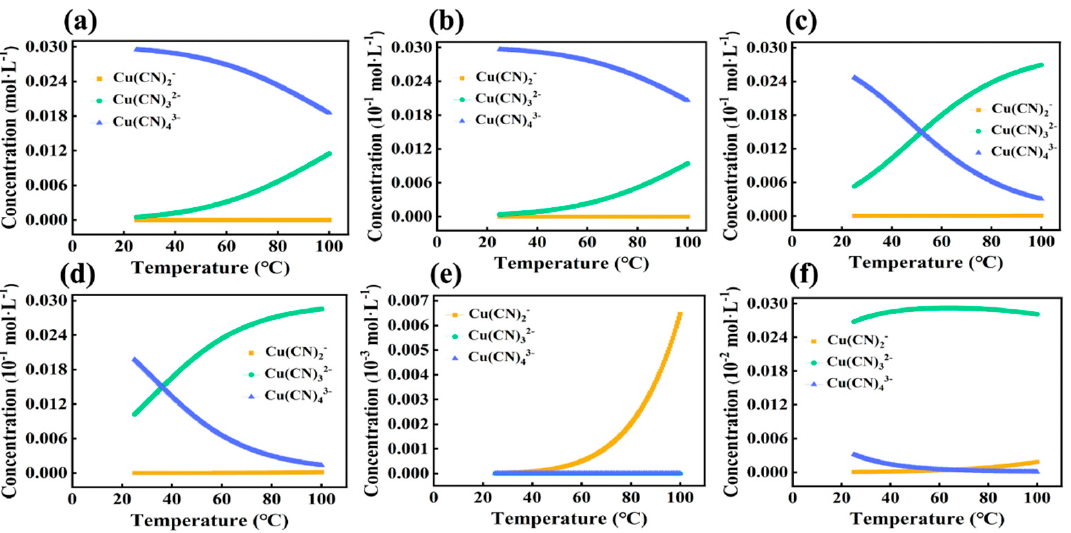
Figure 6. The OLI studio 11.0 was utilized to simulate the distribution of Cu(CN) 2 − , Cu(CN) 32 − , and Cu(CN) 43 − as a function of temperature under six different concentration gradients, with the follow- ing concentrations: ( a ) c(Cu):c(CN) = 0.03:0.3, ( b ) c(Cu):c(CN) = 0.003:0.3, ( c ) c(Cu):c(CN) = 0.003:0.06, ( d ) c(Cu):c(CN) = 0.003:0.03, ( e ) c(Cu):c(CN) = 0.003:0.003, ( f ) c(Cu):c(CN) = 0.0003:0.003.